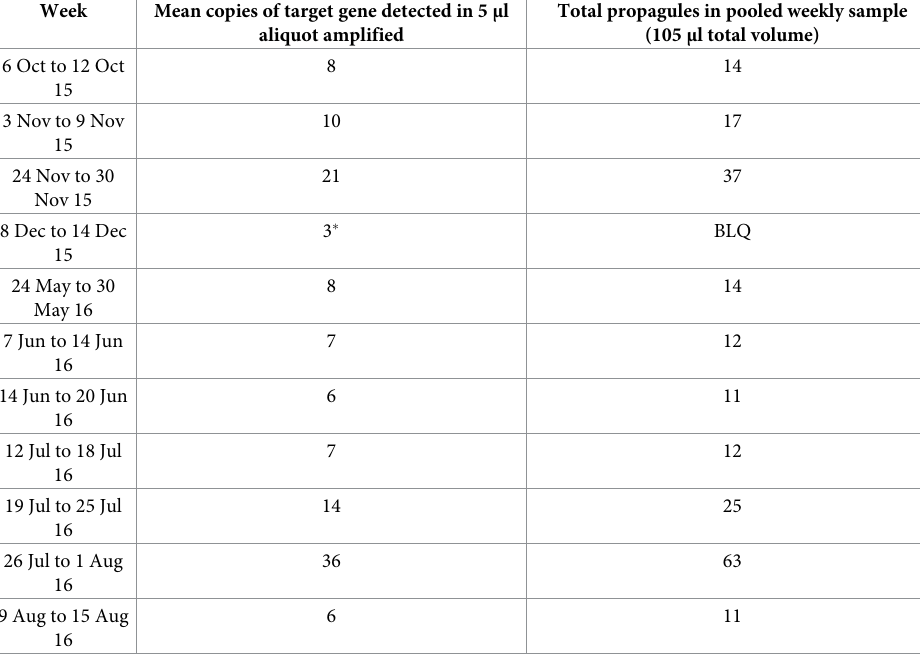
Table 2. Detection of Es . africanus propagules in weekly air samples.